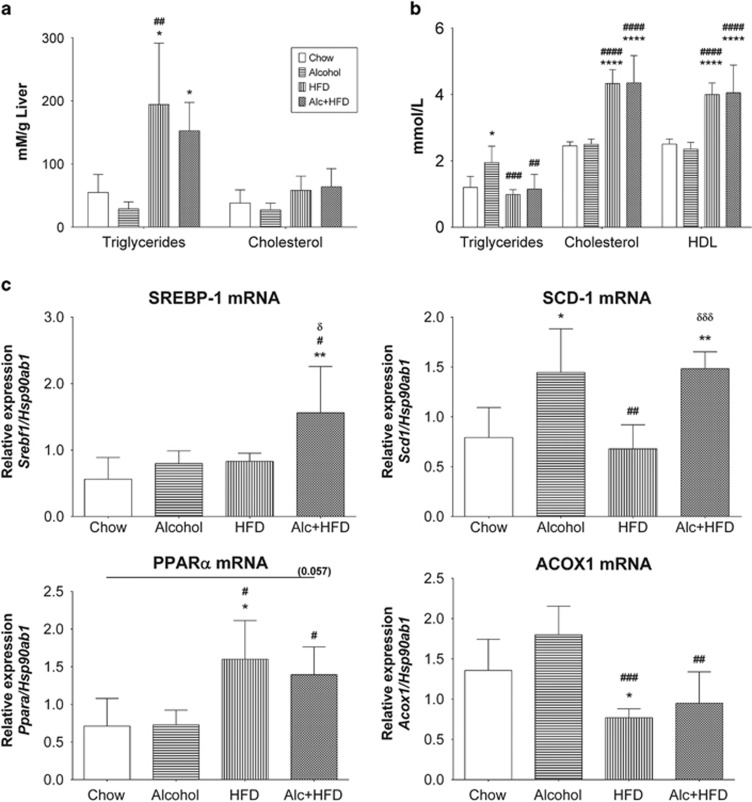
Alcohol and HFD induce hepatic steatosis. (a) HFD and Alc+HFD increased liver triglyceride. Analysis of liver homogenates showed that HFD- and Alc+HFD-treated mice had significantly higher triglyceride per gram of liver compared with livers from Chow- and Alcohol-treated mice (n=5). (b) Alcohol and HFD increased serum triglyceride, cholesterol and HDL. Serum triglyceride concentration was significantly higher in mice treated with Alcohol compared with control. It was significantly reduced with HFD and Alc+HFD when compared with Alcohol alone. Serum from mice treated with HFD and Alc+HFD showed significantly higher cholesterol and HDL than those on Chow diet (n=7–8). (c) Alcohol and HFD altered expressions of lipid processing mRNAs favouring lipid accumulation in the liver (Q-PCR). Alc+HFD induced significant expression of SREBP-1 mRNA compared with all other treatment groups. Alcohol alone and Alc+HFD induced significant expression of SCD-1 mRNA compared with Chow. SCD-1 expression was significantly reduced in HFD compared with Alcohol alone and Alc+HFD. mRNA expression of PPARα was significantly induced in HFD and Alc+HFD from both Chow and Alcohol treatment groups. HFD significantly reduced ACOX1 mRNA expression compared with Chow and Alcohol, while Alc+HFD significantly reduced ACOX1 expression compared with Alcohol. mRNA expression of target genes was normalised using housekeeper Hsp90ab1 (n=5–6). Data are mean ±s.d. *P<0.05 from Chow, **P<0.01 from Chow, ****P<0.0001 from Chow; #P<0.05 from Alcohol, ##P<0.01 from Alcohol, ###P<0.001 from Alcohol, ####P<0.0001 from Alcohol; δP<0.05 from HFD, δδδP<0.001 from HFD. HDL, high density lipoprotein; SREBP-1, sterol response element binding protein-1; SCD-1, stearoyl-CoA desaturase-1; Proliferation peroxisome activated receptor α, PPARα ACOX1, acyl-CoA oxidase 1.